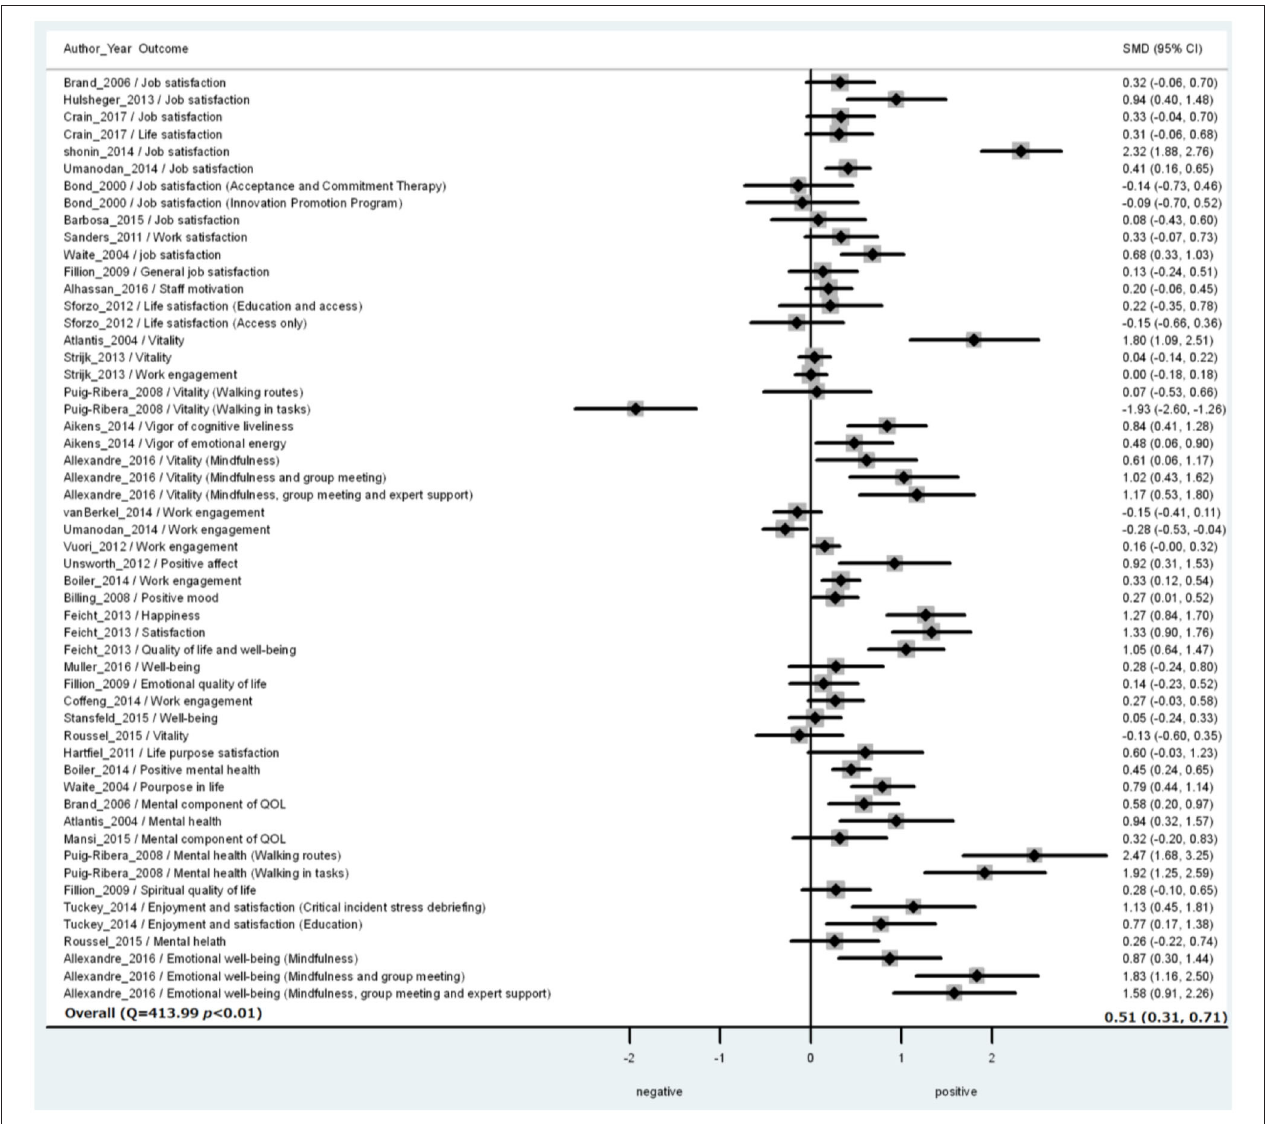
FIGURE 2 | Forest plot of intervention effects [standard mean differences (SMD)] on subjective well-being (SWB) among 31 studies. Each study may include multiple outcomes. SMD and 95% CIs for an individual study were calculated based on a combination of study and outcome, where a positive effect means favorable results for an intervention group compared to a control group. The overall effect was estimated by using a three-level random-effect model considering multiple outcomes nested in the same studies. The heterogeneity was tested by Q